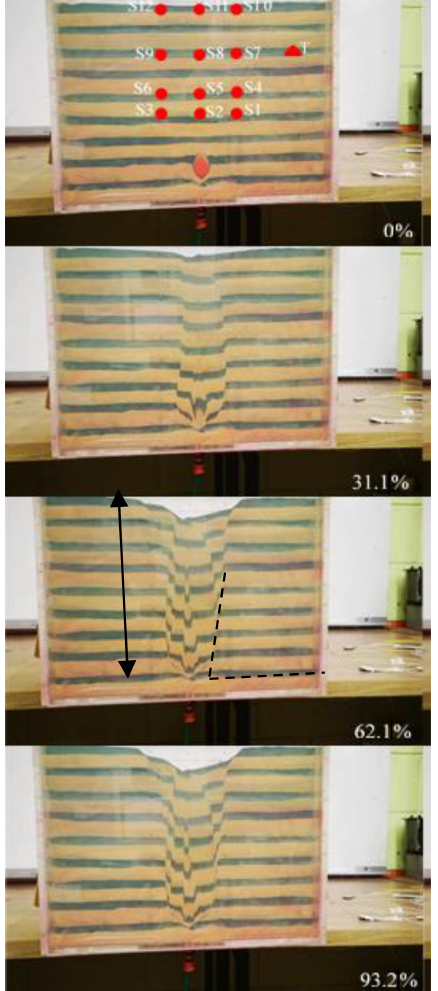
Figure 4. Failure surfaces with medium compact sand fill, the per- centages refer to balloon volume reduction (photo taken by Jean- dre